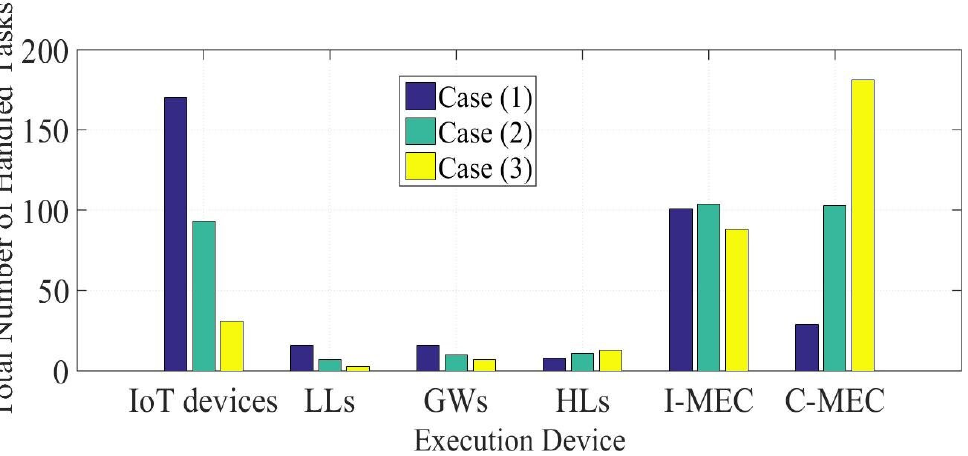
Figure 12. Total number of handled tasks of heterogenous deployed devices and servers for the three considered cases of the first scenario.